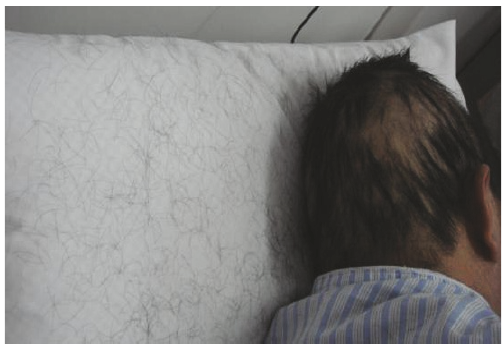
Figure 1: Hair partial loss (February 20, 2014).